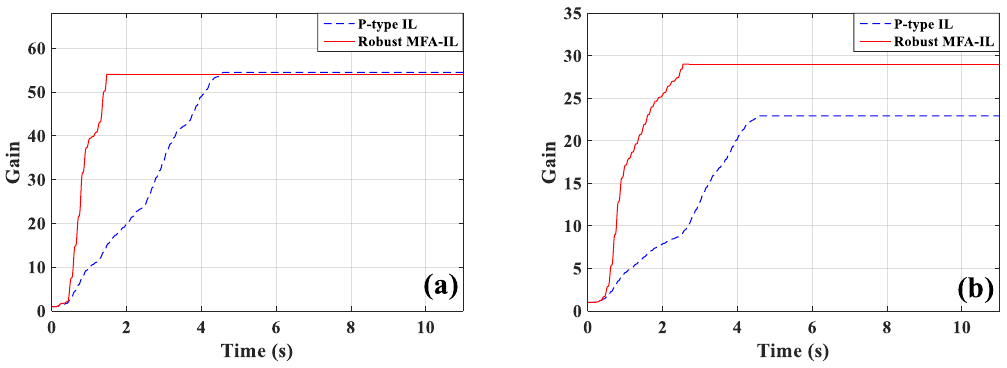
Figure 12. The learning processes of feedback gains: ( a ) Actuators a / b , ( b ) actuator c.